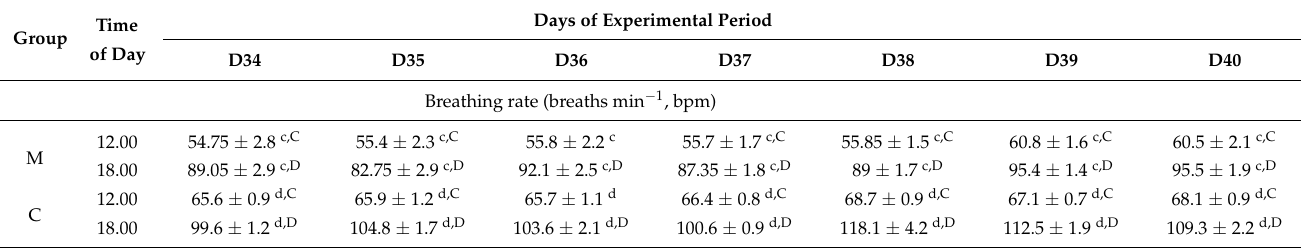
Table 1. Rectal temperature and breathing rate (mean ± SEM) in group M (melatonin) and group C